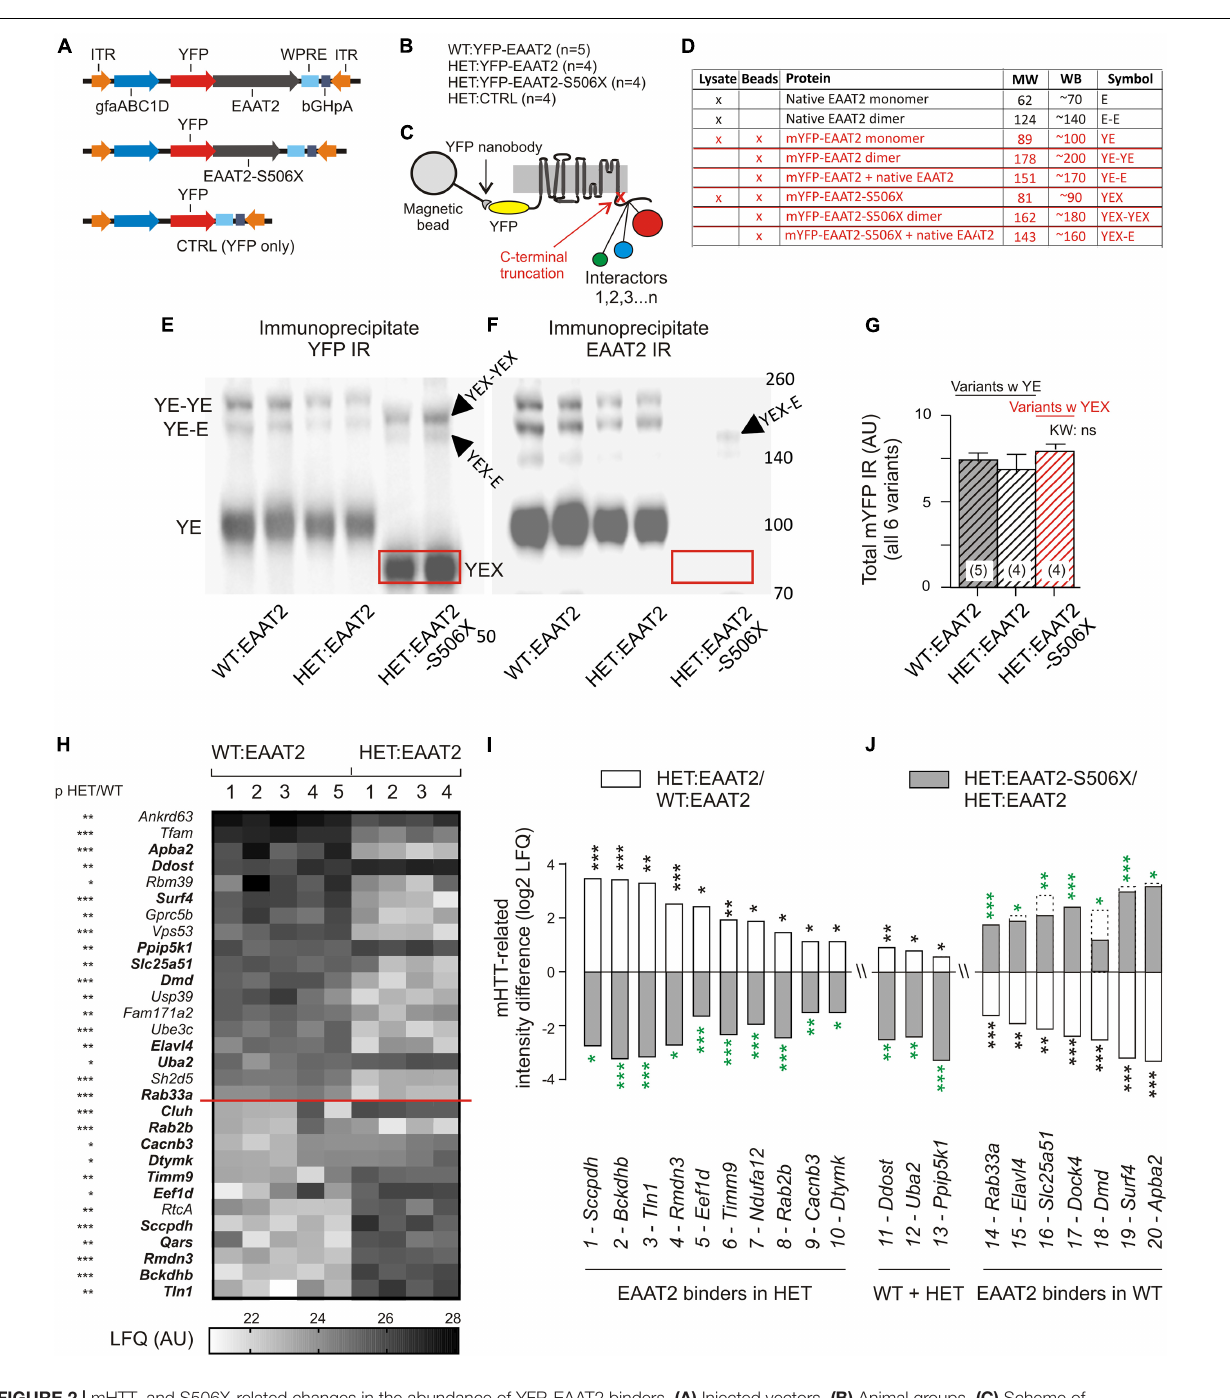
Frontiers in Cellular Neuroscience |